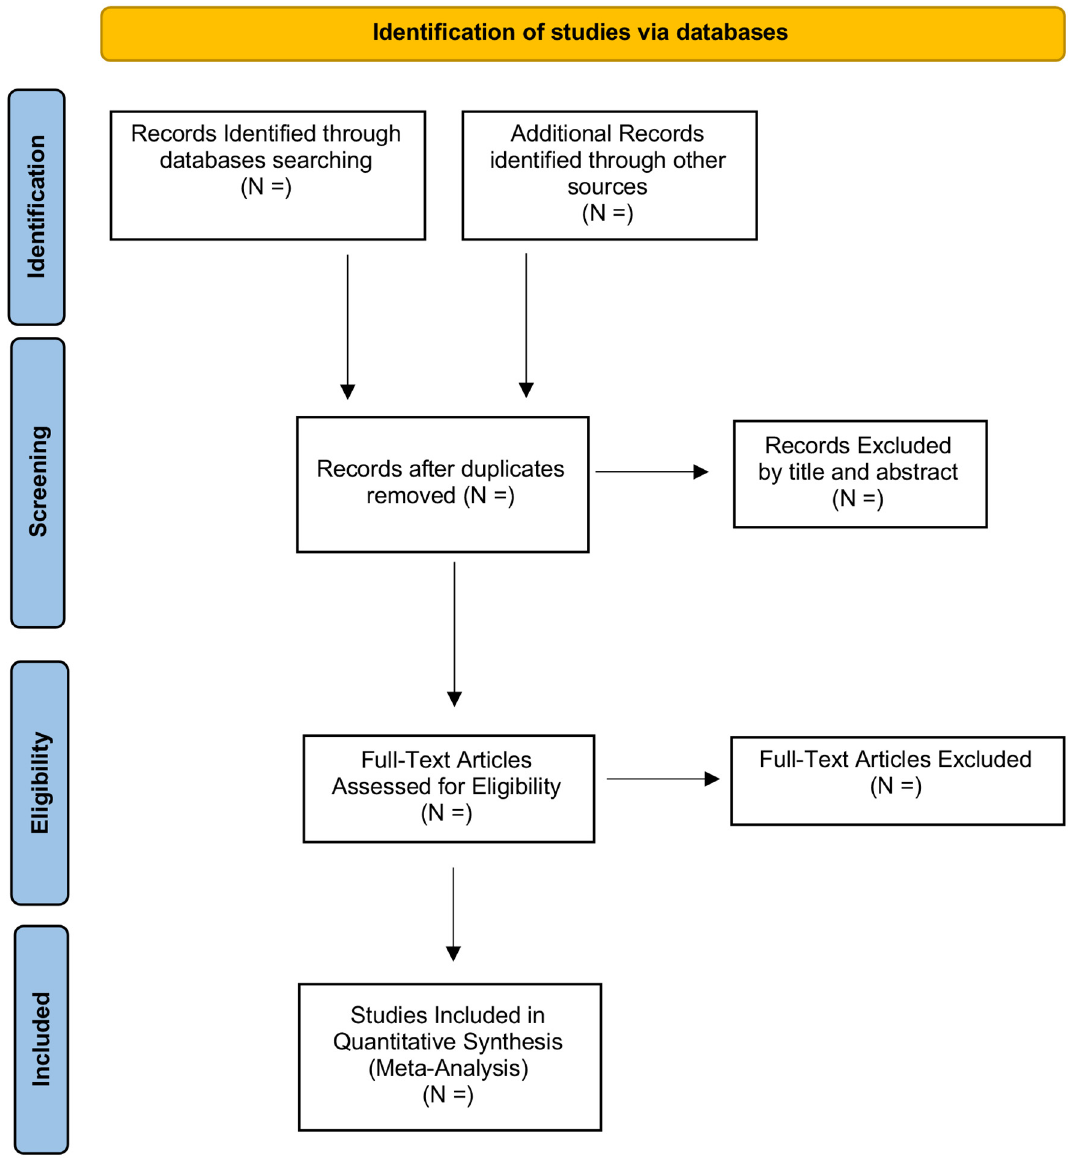
Figure 1. Preferred Reporting Items for Systematic Review and Meta-analysis (PRISMA) flowchart of searching and screening.